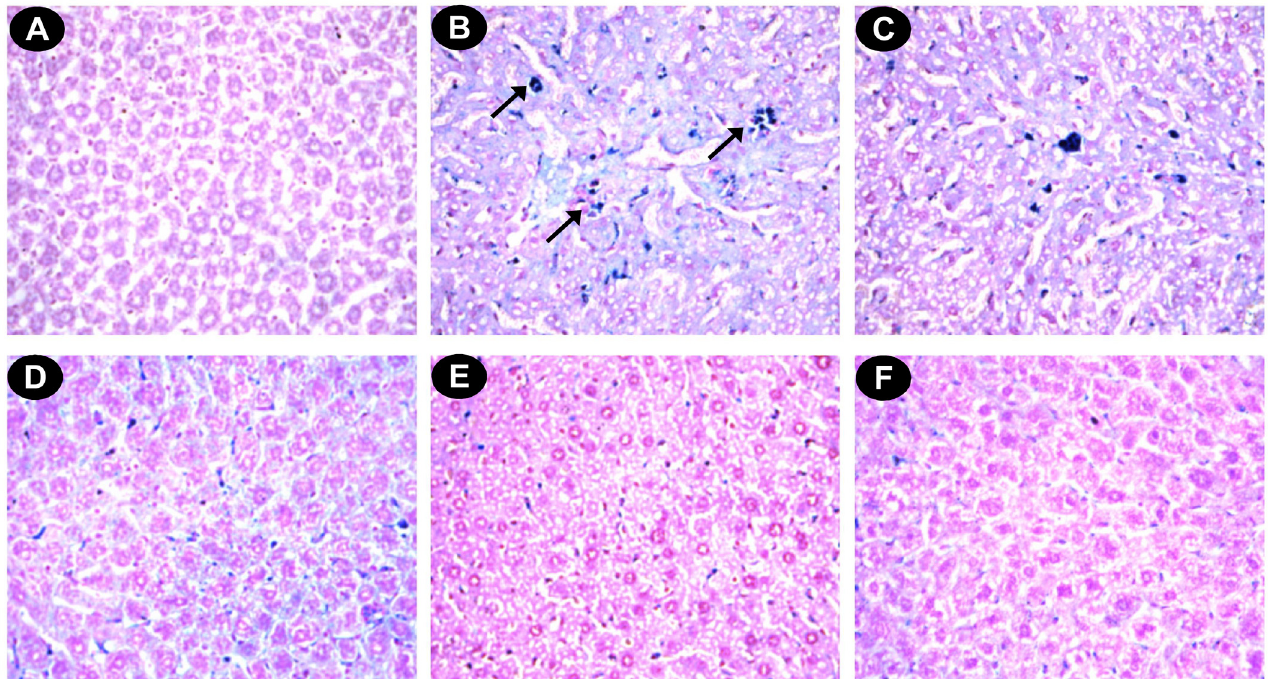
Fig 8. Photomicrograph of mice liver sections (Perls ’ staining) ×400. (A) Control mice liver. (B) Iron-overloaded (iron dextran, 100 mg/kg b.w.) liver section showing hemosiderin in blue (indicated by arrows) (C) Liver section treated with iron dextran + 50 mg/kg b.w. DBME shows less hemosiderin. (D) Liver section treated with iron dextran + 100 mg/kg b.w. DBME. (E) Liver section treated with iron dextran + 200 mg/kg b.w. DBME. (F) Liver section treated with iron dextran + 20 mg/kg b.w. desirox shows nearly no hemosiderin. S100 and S200 show very less hemosiderin indicating a trend of restoration of healthy liver with reduced iron content.